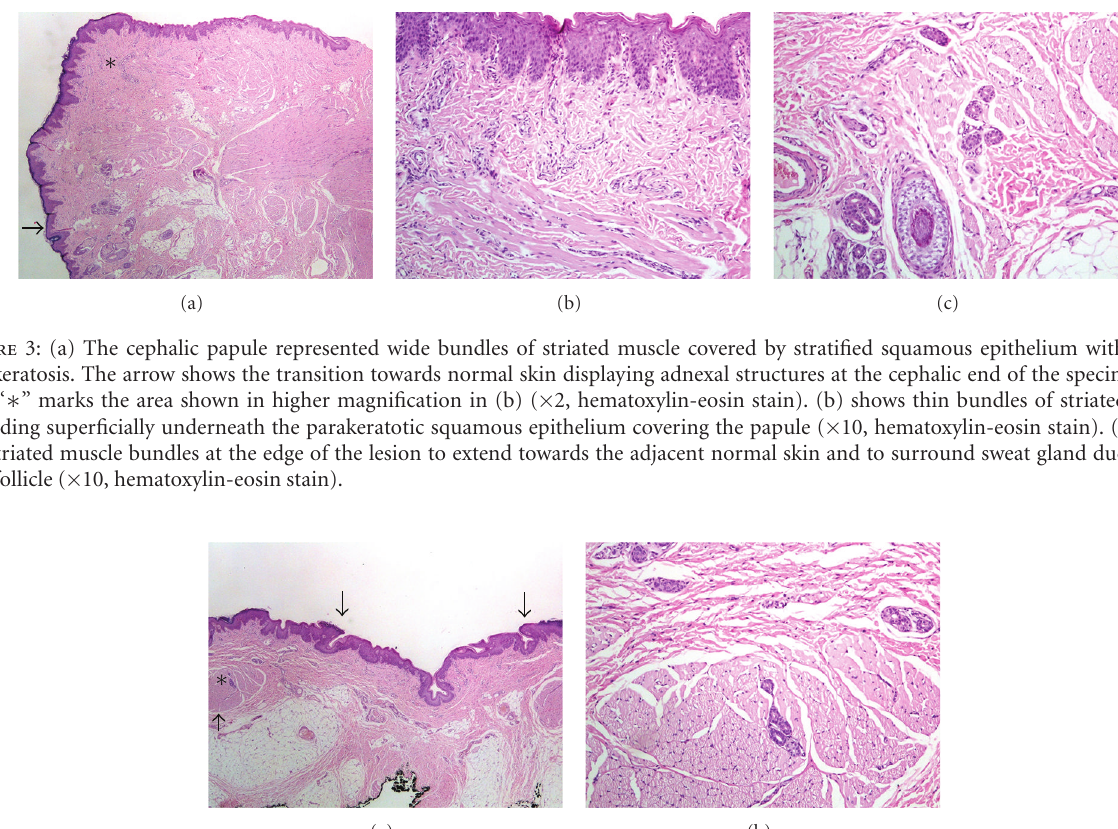
of the neck. During this period the parents were asked